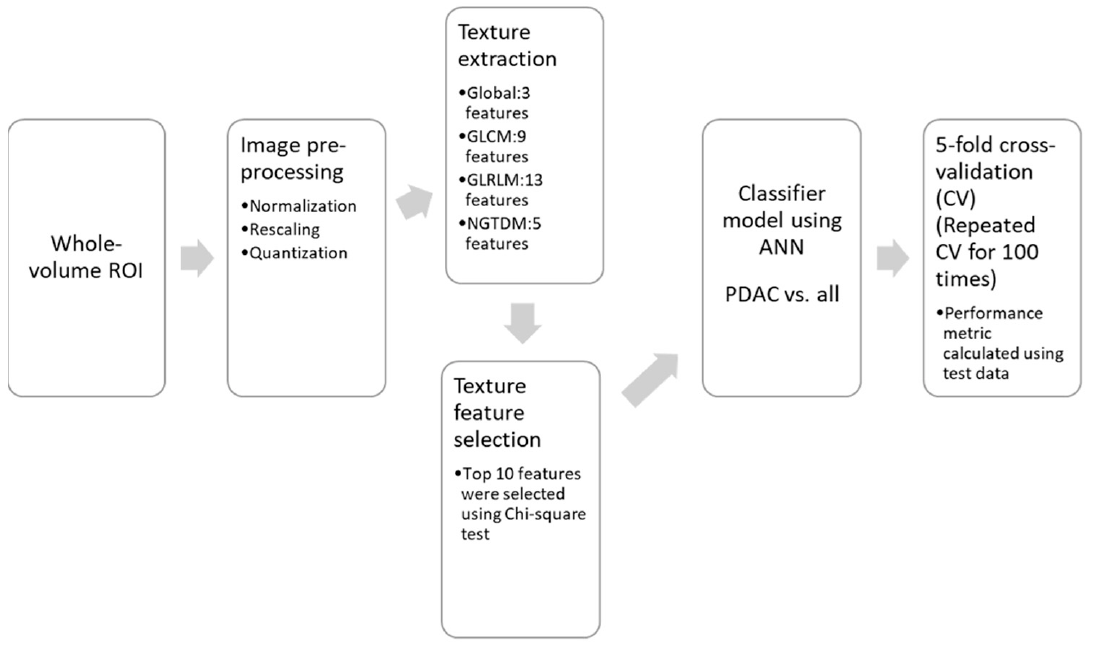
Figure 2. Flowchart representing the machine learning-based classification of pancreatic masses using texture features of ADC and IVIM-DKI parameters.